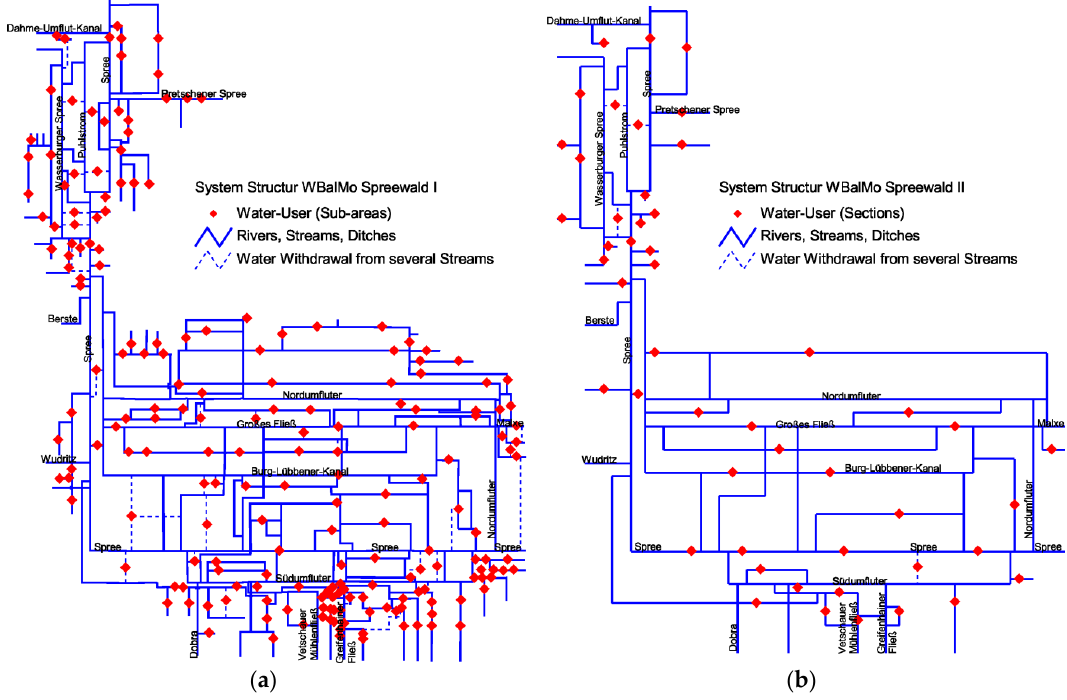
Figure 6. Structure of the models WBalMo Spreewald I ( a ) and WBalMo Spreewald II ( b ) with stream network and water users (sub-areas/sections).